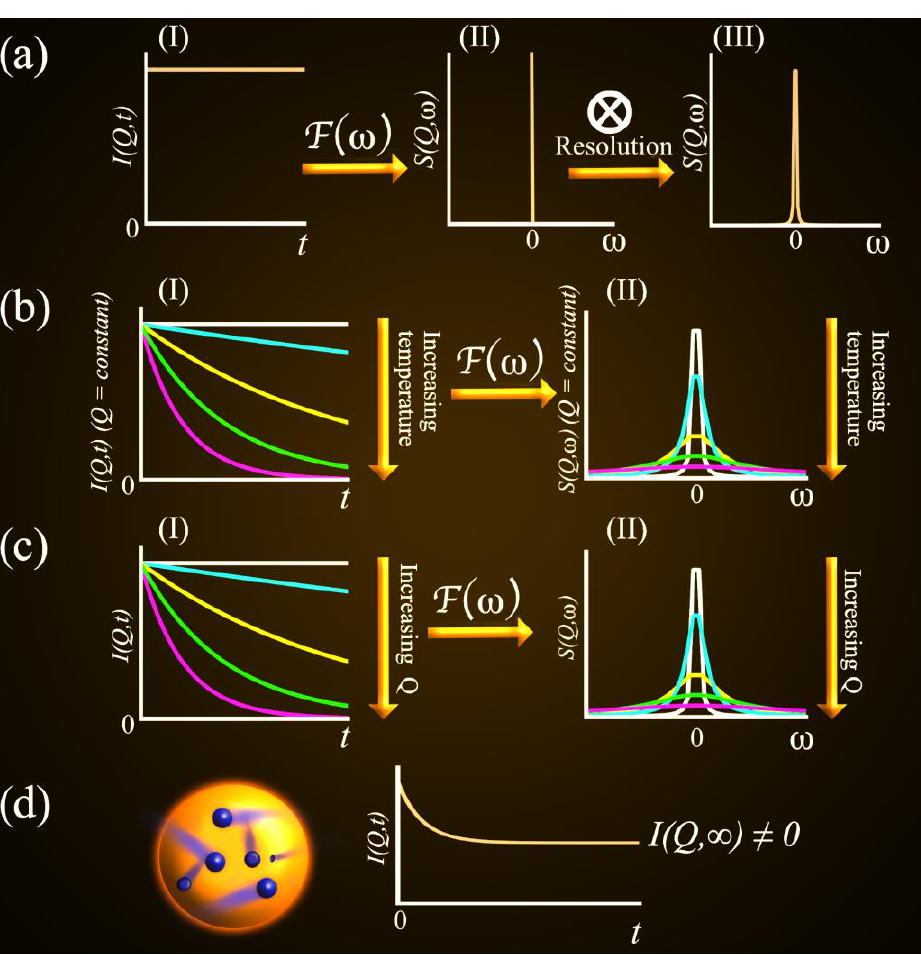
Figure 3. Schematics of the relationship between I incoh ( Q , t ) and S incoh ( Q , ω ). In ( a ), curve a-I shows the expected behavior of I incoh ( Q , t ) for a static particle where no exchange of energy occurs between the incoming neutrons and the sample. As shown in a-II, after a time-Fourier transformation of I incoh ( Q , t ), one obtains a δ -function-shaped S incoh ( Q , ω ), which broadens when convoluted with the experimental resolution (see a-III). In ( b ), the particles under analysis perform motions upon, for example, heating and I incoh ( Q , t ) gradually decays (b-II) and S incoh ( Q , ω ) becomes broader (b-II). In ( c ), an unconstrained diffusive motion is depicted, which leads to a gradual decay of I incoh ( Q , t ) over Q (c-I) reaching the limit of I incoh ( Q , ∞ ) = 0, and S incoh ( Q , ω ) broadens as a function of Q (c-II). In ( d ), the motions of particles within a constrained geometry are depicted and I incoh ( Q , t ) plateaus at a finite value at t → ∞